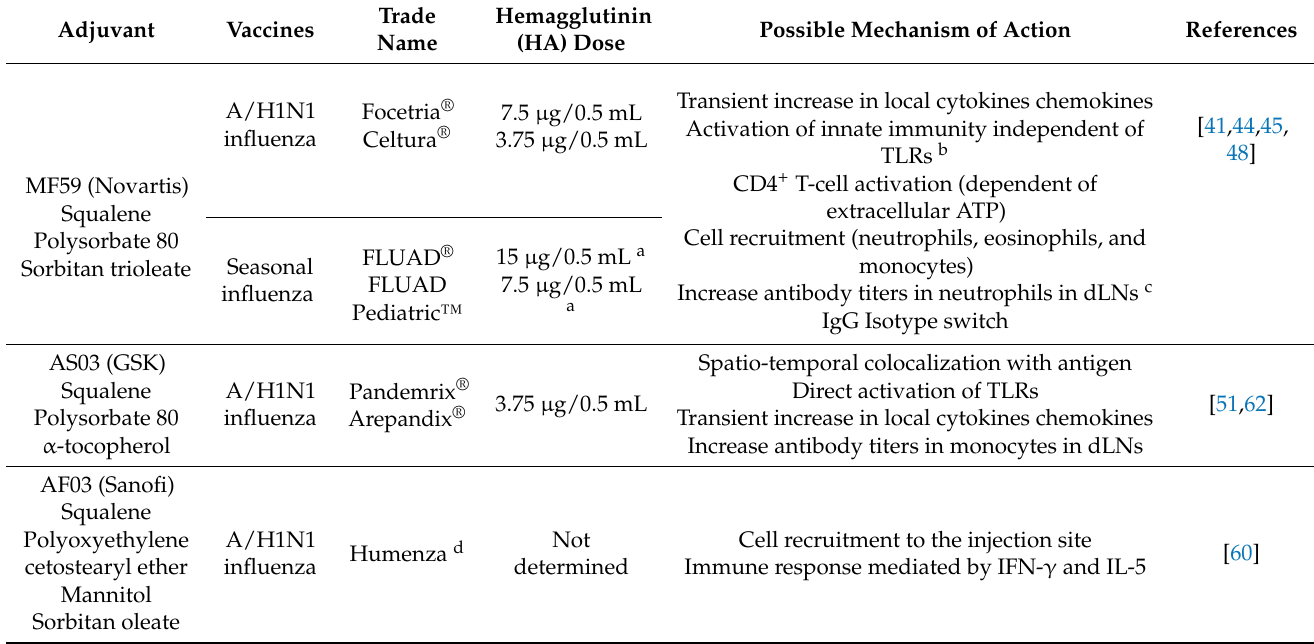
Table 1. Squalene-based adjuvants composition and possible mechanisms of